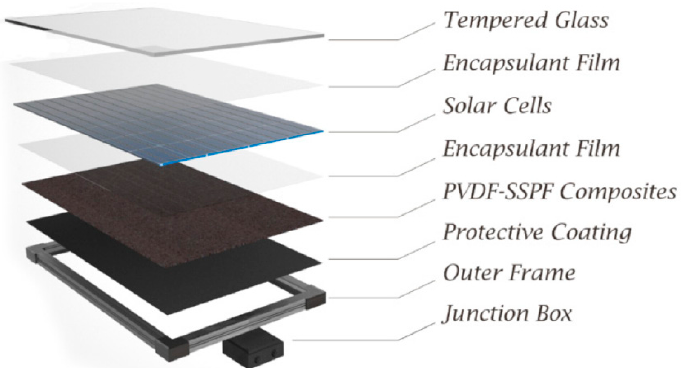
Figure 1. Typical structure of a modern photovoltaic generator (PVG). Reprinted with permission [5]; 2019; MDPI.